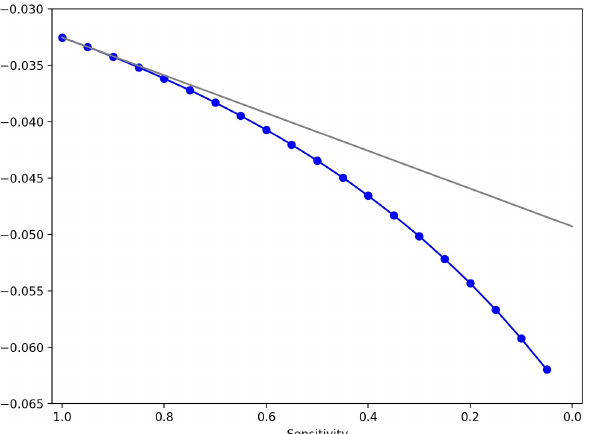
Figure 8. The change in steady-state voltage with the change in g t g t represents the slope from 1 to Sens